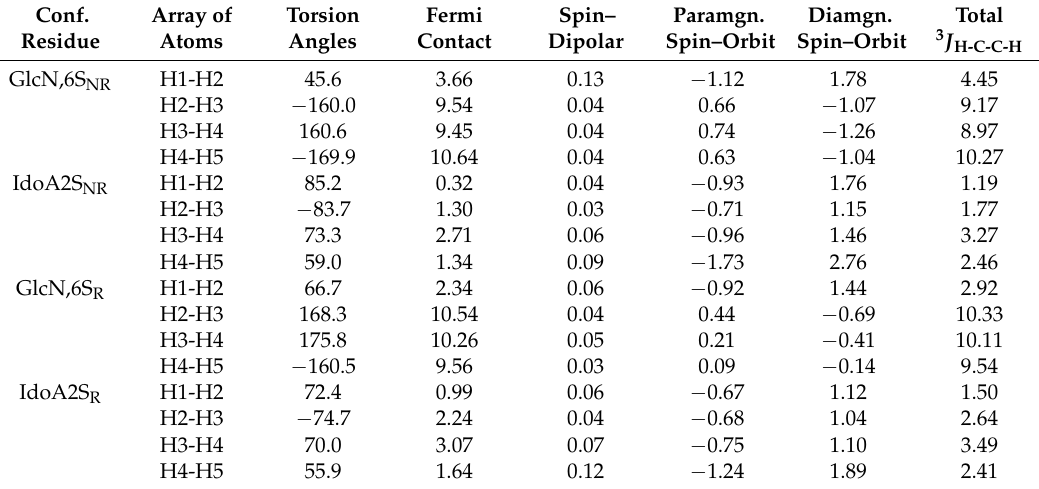
Table 5. DFT–computed (B3LYP/6-311+(d,p)) Fermi contact, spin–dipolar, paramagnetic spin–orbit and diamagnetic spin–orbit contributions to the three-bond proton–proton coupling constants (values in Hz) in form 1 of the heparin tetrasaccharide. Total 3 J H-C-C-H magnitudes are listed in the final column. Conf.